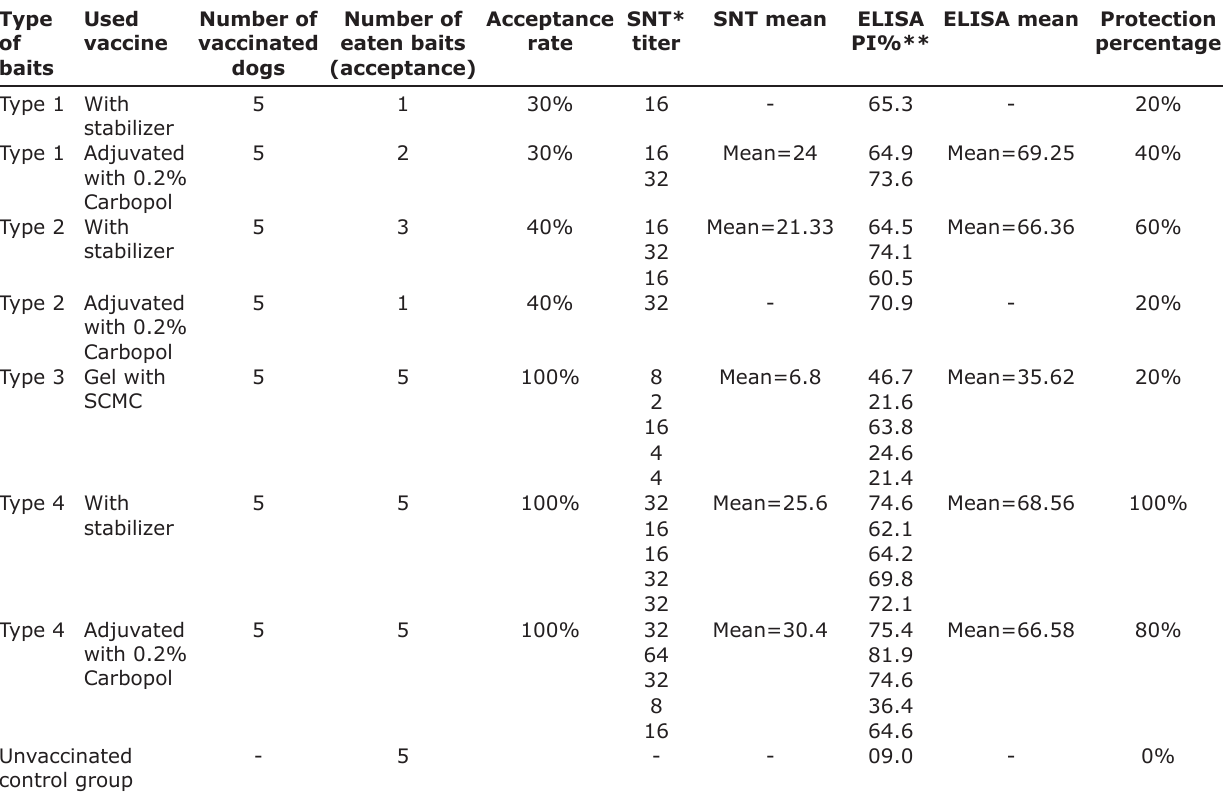
Table-3: Determination of the acceptance and efficacy of the different type of rabies vaccine oral baits. Type Used of vaccine baits